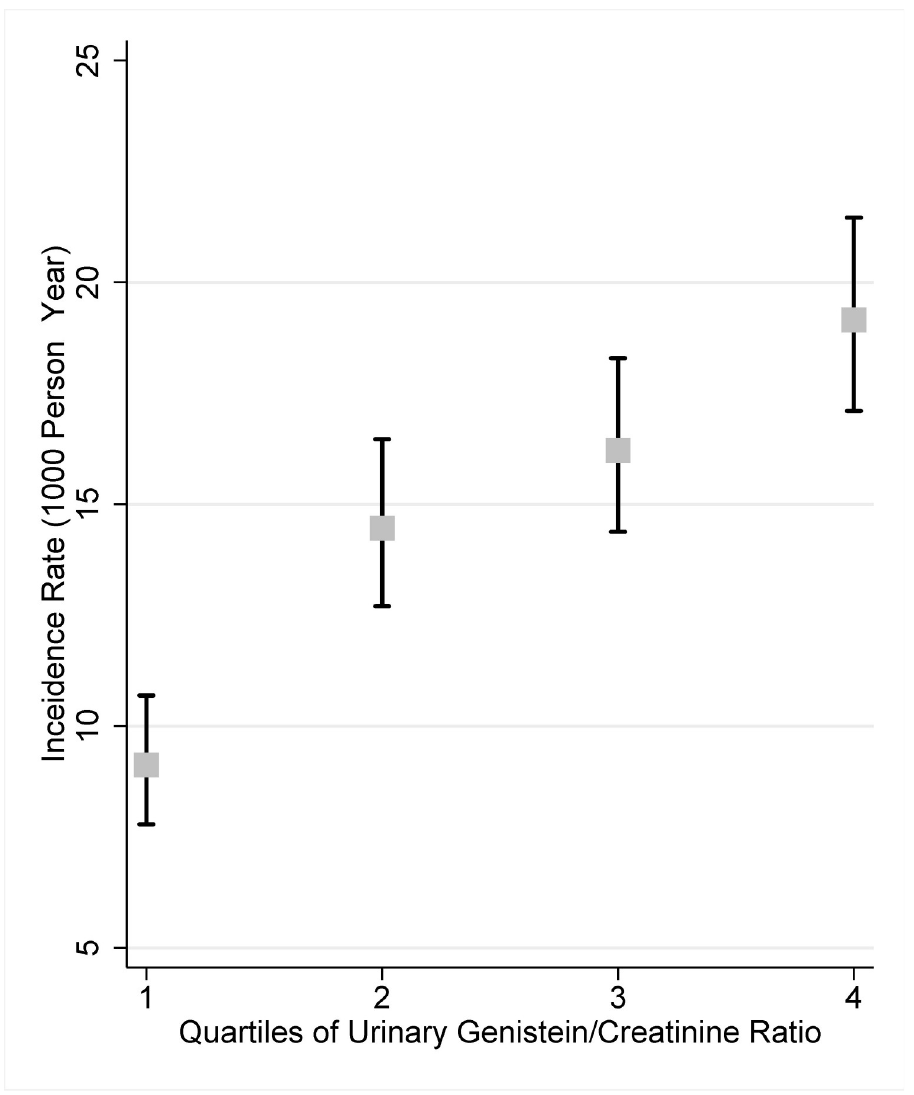
Fig 1. Mortality incidence rates (per 1000 person-years) for each quartile of normalized urinary genistein levels. The incidence rate of death was significantly lower (p < 0.001) in the first quartile of normalized urinary genistein (nUG) compared to the fourth quartile of nUG. The mortality incidence rate was 9.1 deaths per 1000 person-years (CI 7.8 to 10.7) in the first quartile versus 19.2 deaths per 1000 person years (CI 17.1 to 21.5) in the fourth quartile.